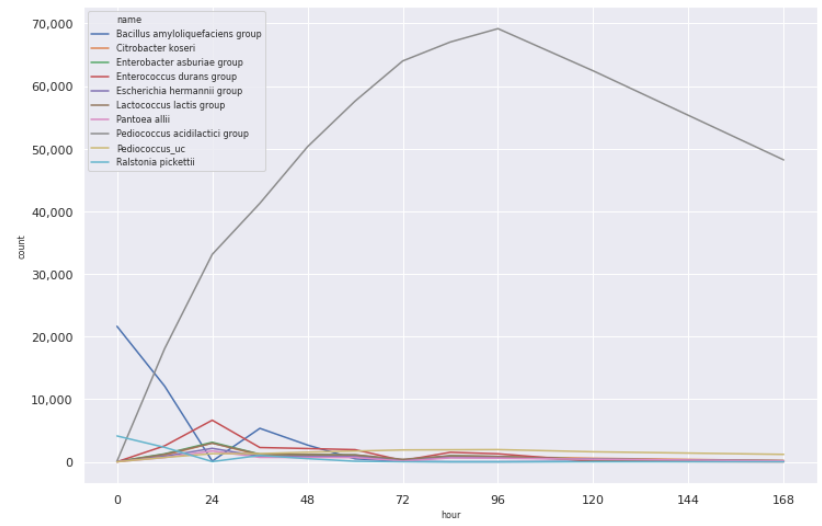
Figure 7. Original count of the microbial